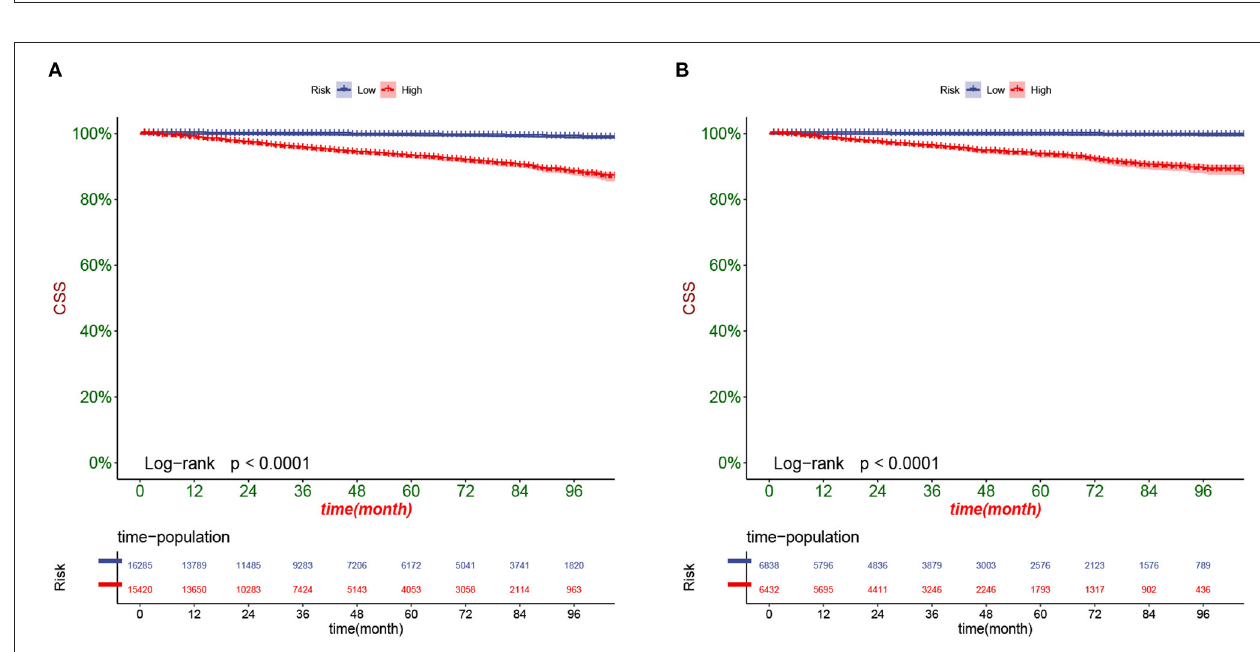
FIGURE 6 | Kaplan-Meier curves of patients in the low-risk and high-risk groups in the training set (A) and validation set (B) .